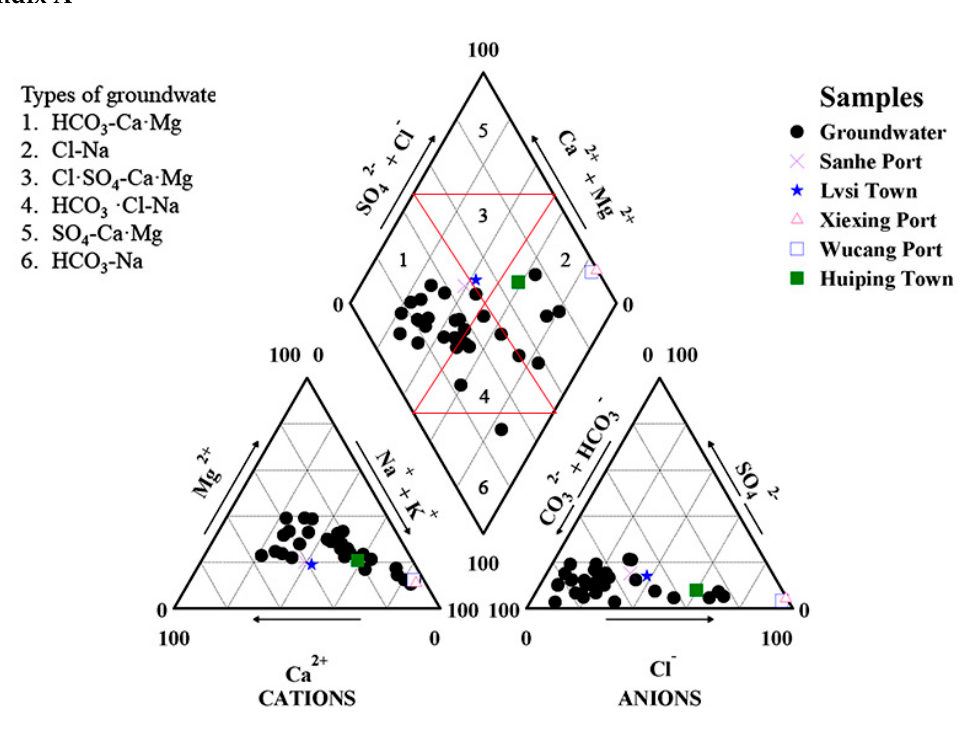
Figure A1. Piper diagram of groundwater and surface water.